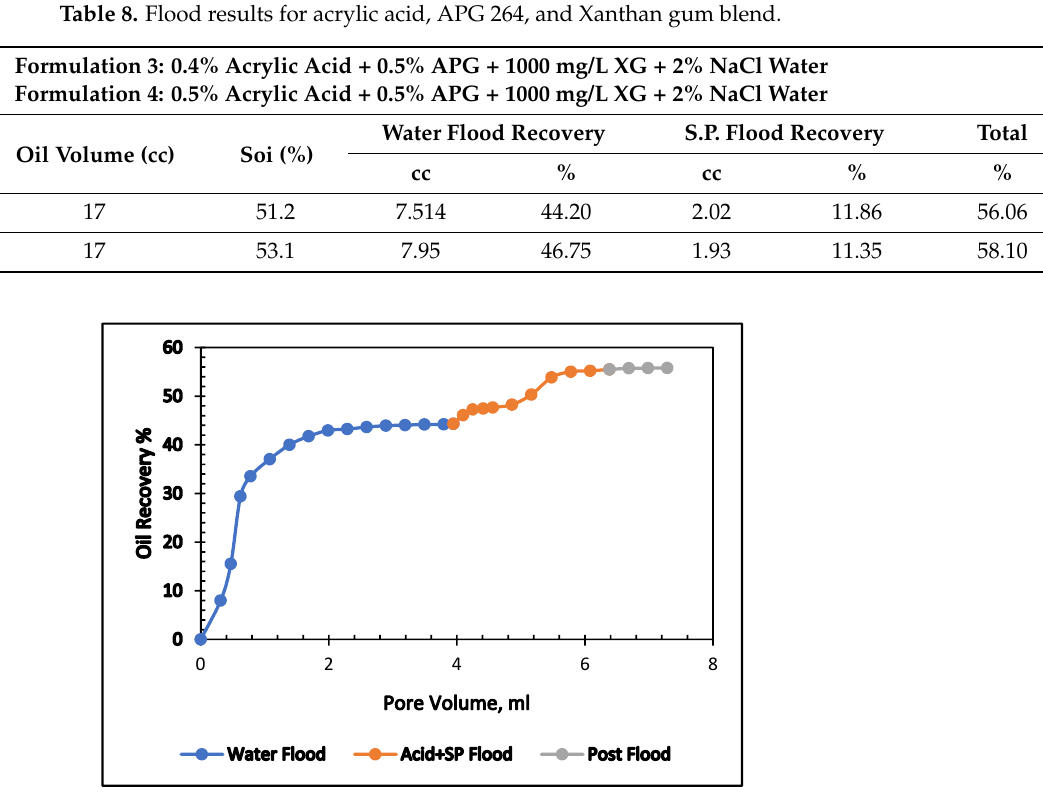
Figure 13. Total oil production from the carbonate core after brine, butanone, and SP mixture, fol- lowed by a post-flood with brine.